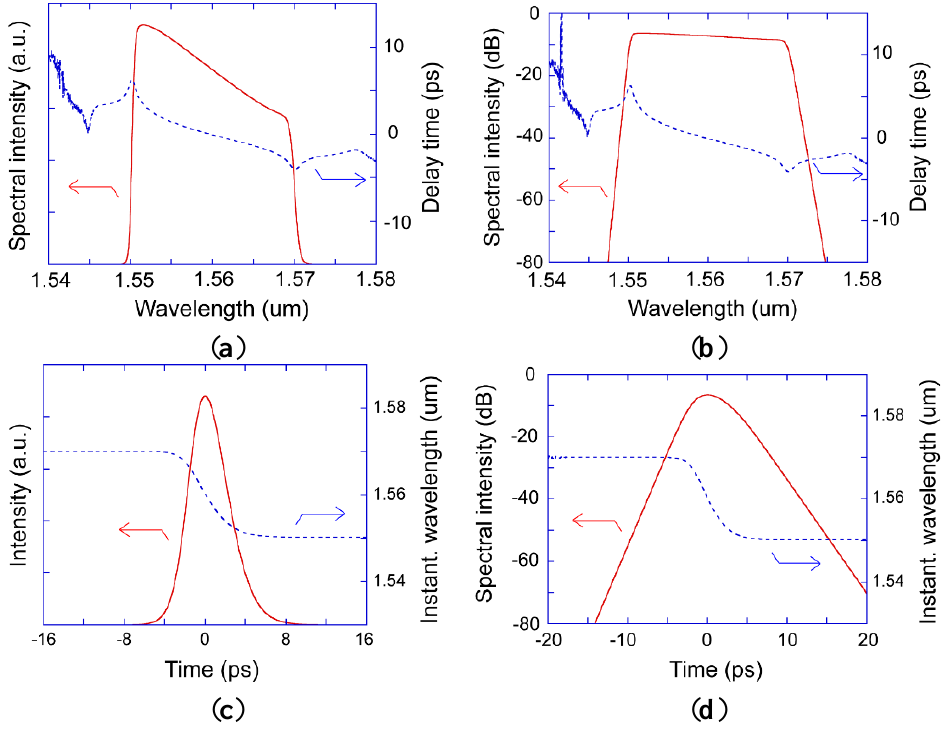
Figure 8. Characteristics of output pulse for dissipative-soliton mode-locking regime. ( a , b ) Spectral shapes on linear and log scales. ( c , d ) Temporal shapes on linear and log scales. Variations of the spectral and temporal shapes of the output pulse for the initial mode-locking process are shown as movies in Media 3 and 4.